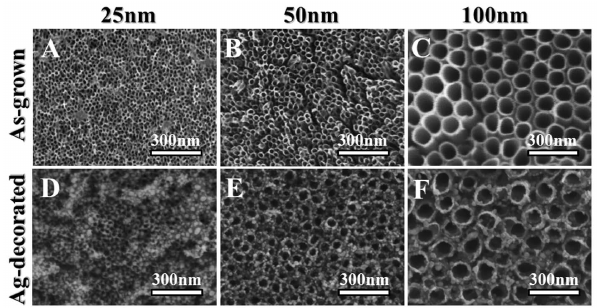
Figure 1. SEM images of self-organized TiO 2 nanotubes with different diameters. The as-grown ( A – C ) and Ag-decorated ( D – F ) nanotubes had diameters of 25, 50, and 100 nm, respectively.